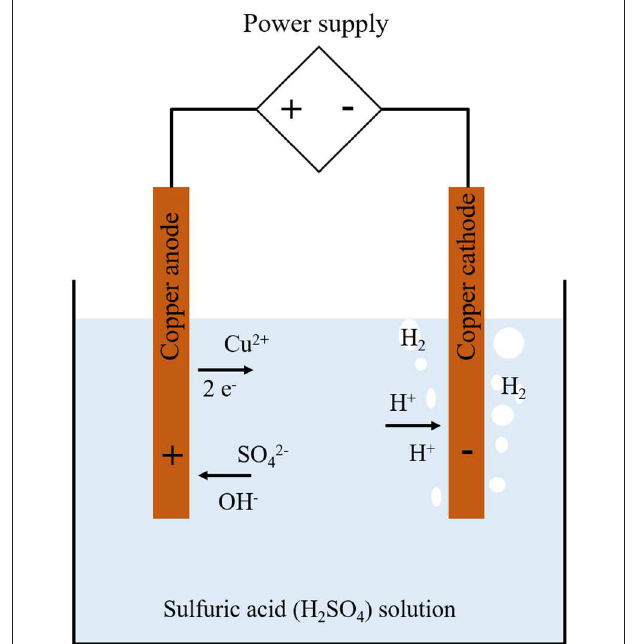
FIGURE 1 | Scheme of a sulfuric acid electrolysis